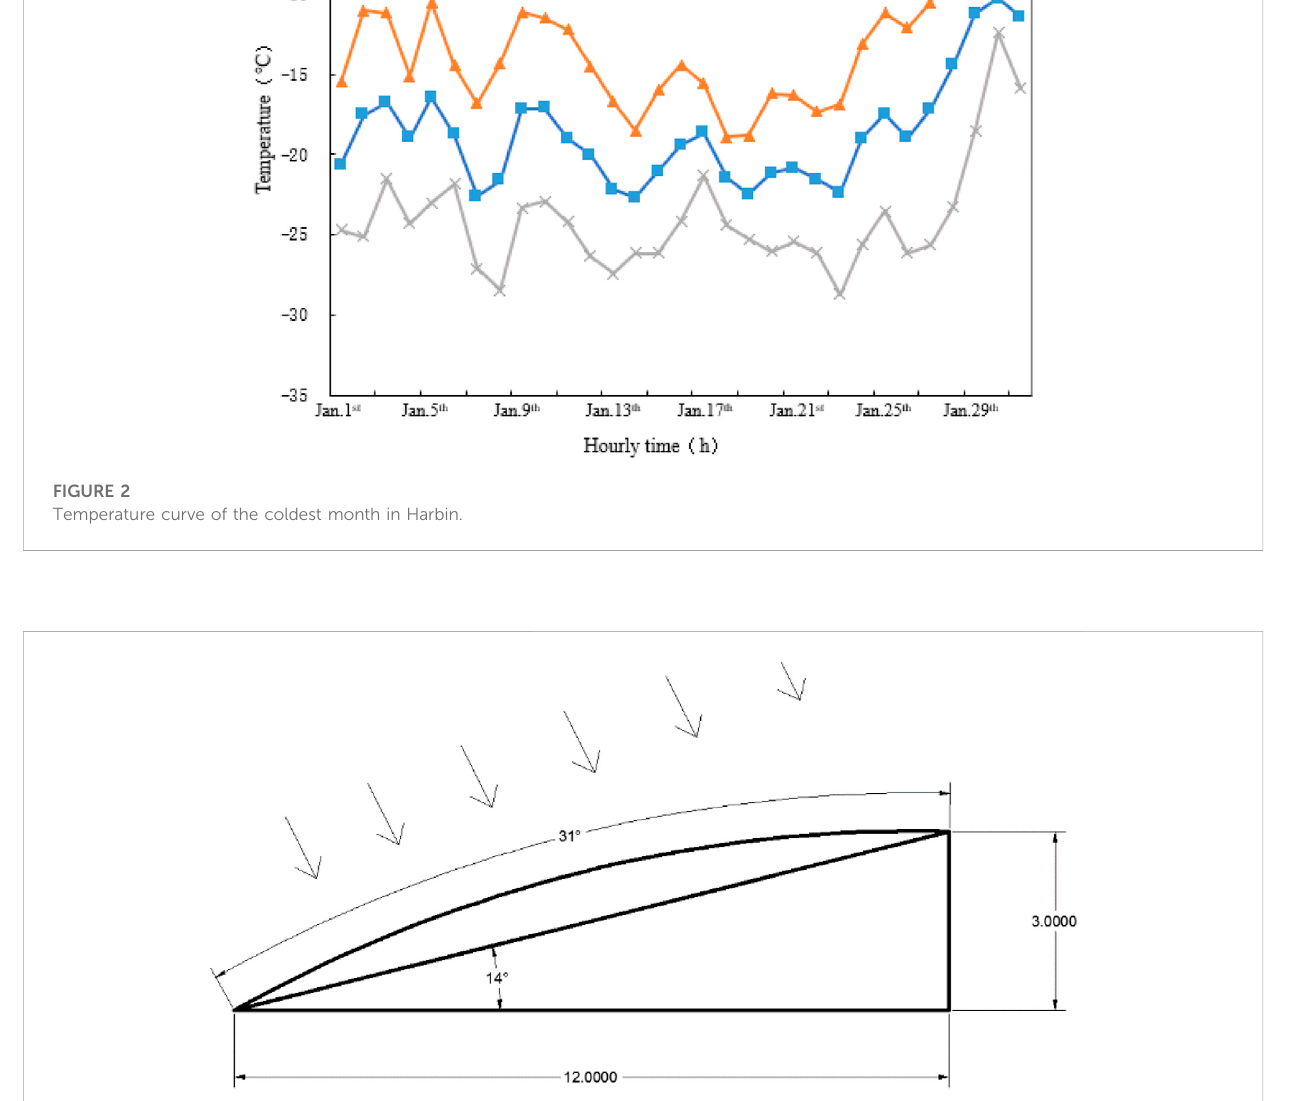
FIGURE 3 Sectional structure diagram of the side of the